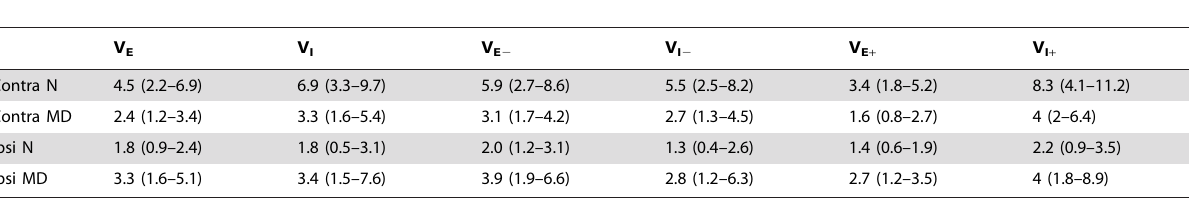
Table 2. Effects of offsetting equilibrium potentials V E and V I on g E and g I estimates.